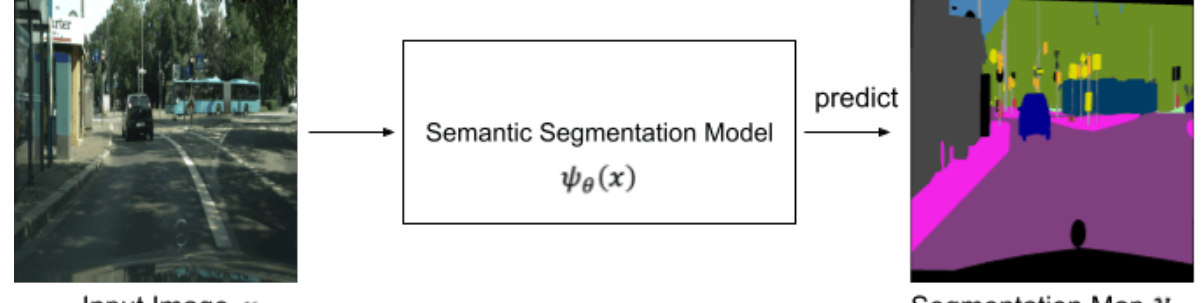
Figure 1. Overview of semantic